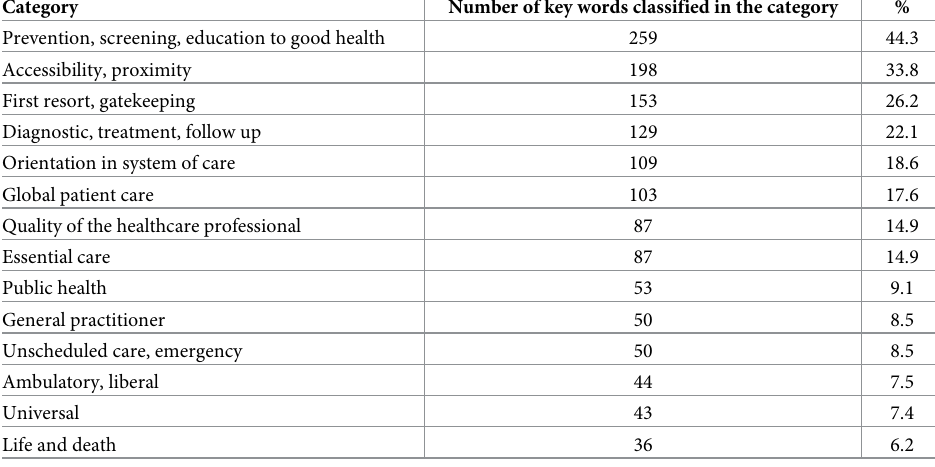
Table 2. Classification of key words from open–ended